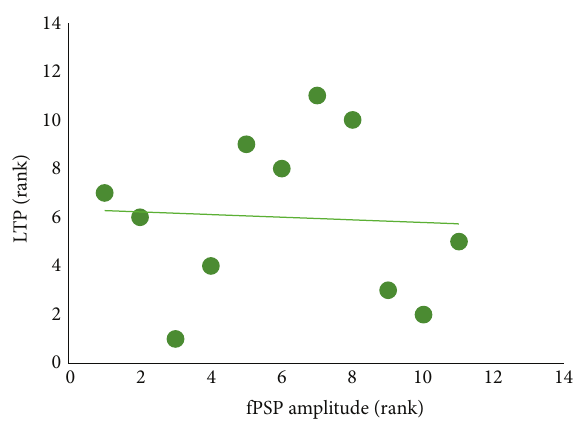
Figure 4: Baseline (pre-theta-burst stimulation) amplitude of the second field postsynaptic potentials (fPSPs) peak and levels of long- term potentiation (LTP) in rats treated with fluoxetine ( 𝑛 = 11 ). Data are expressed as rank, with Rank 1 indicating the highest fPSP amplitude and greatest level of LTP. Note the absence of a significant correlation ( 𝑃 > 0.05 ) between the two